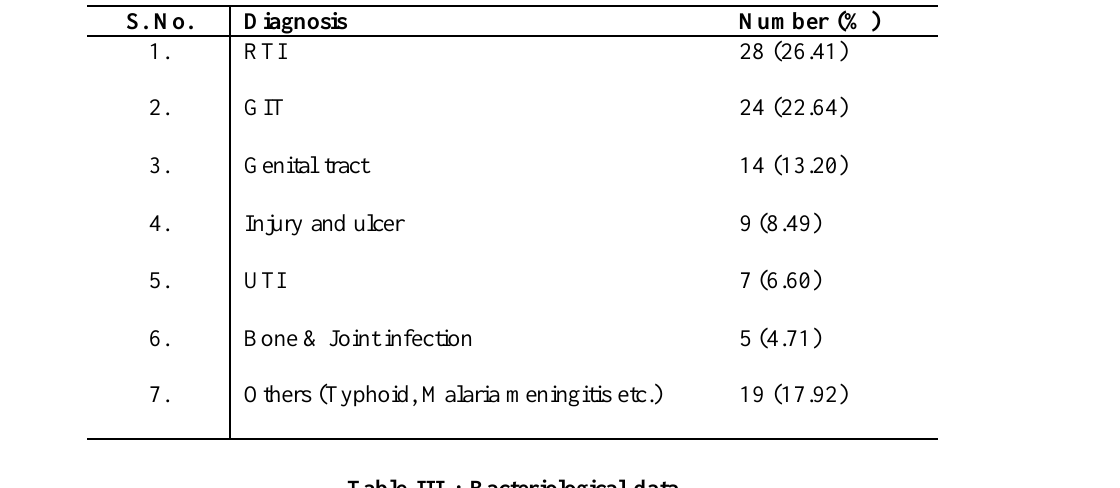
Table III : Bacteriological